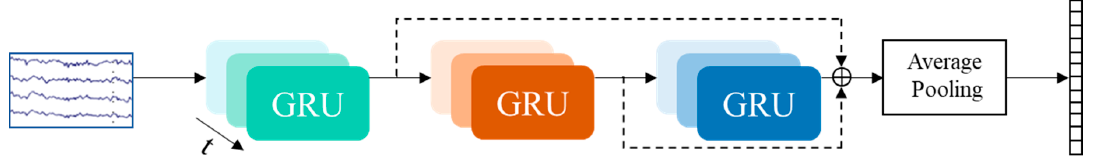
Figure 3. The example architecture of 3-layer stacked Gated Recurrent Unit (GRU) model. The dashed lines denote skip connections.